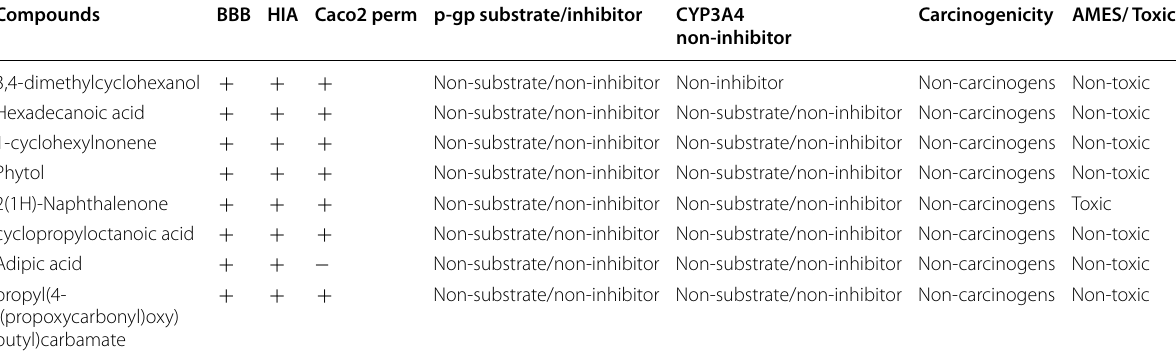
Table 2 In silico ADME toxicity screening of the compounds